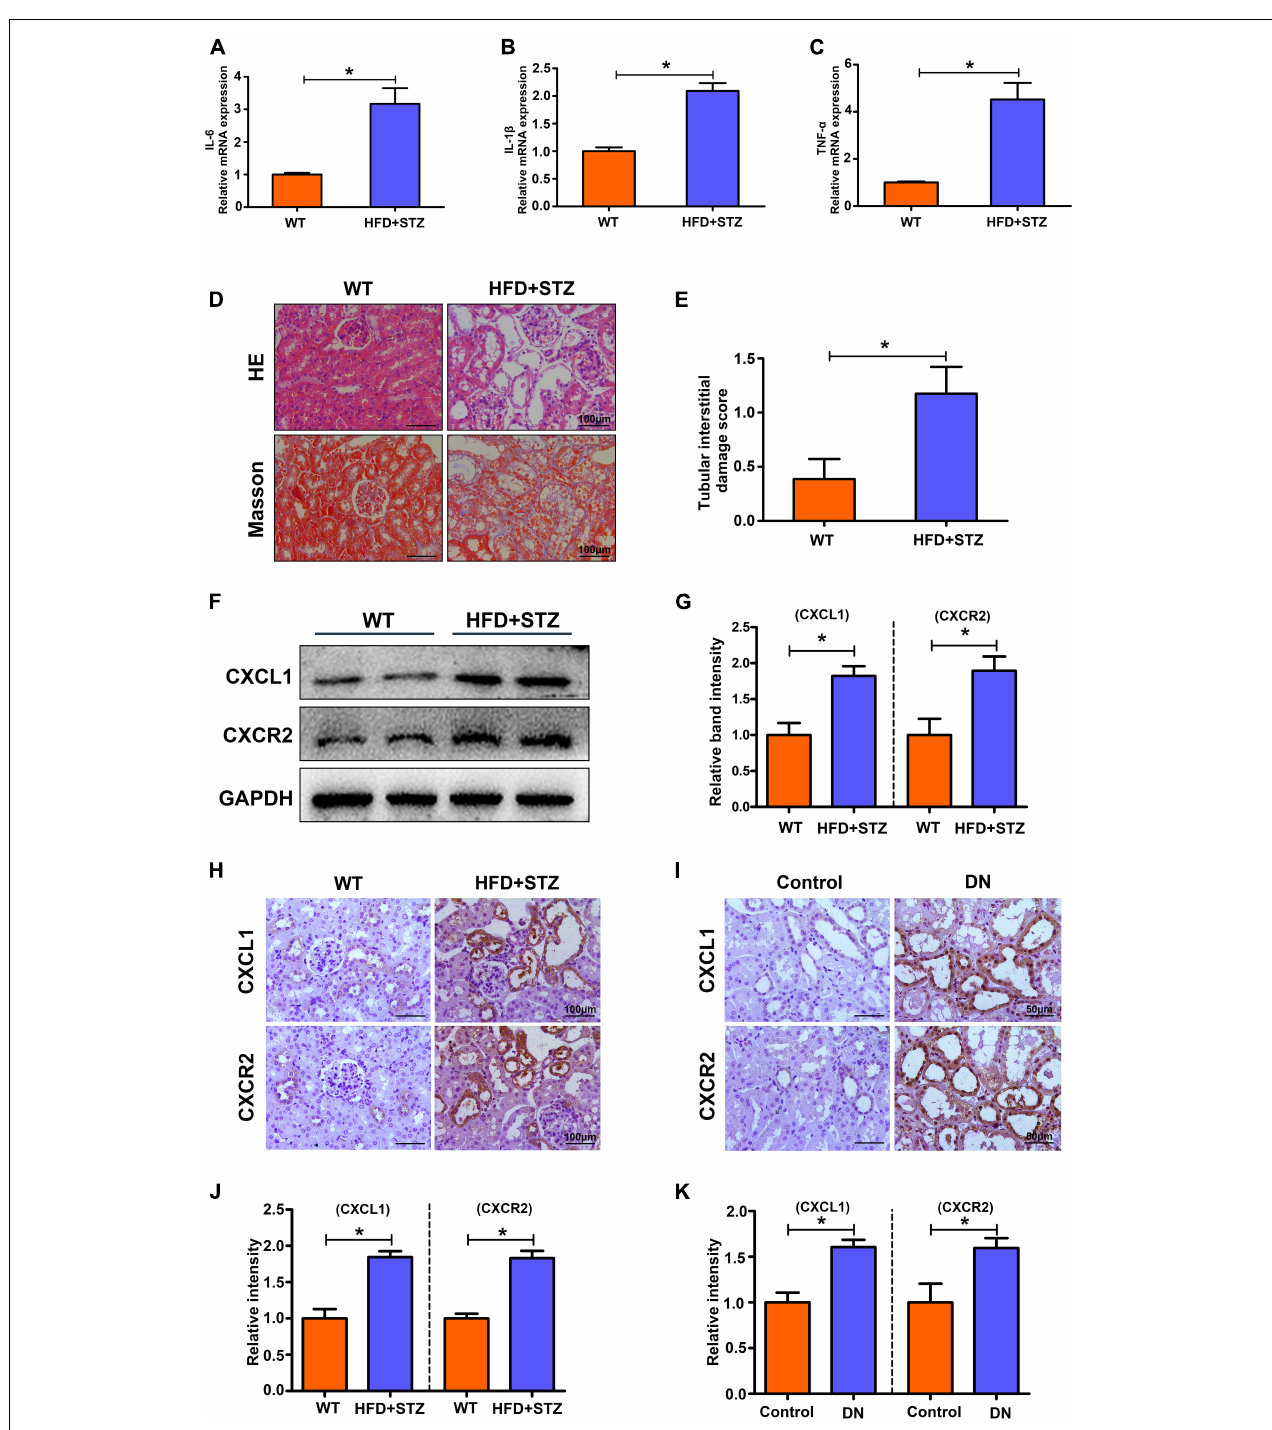
FIGURE 2 | Increased inflammation levels and upregulated CXCL1 or CXCR2 expression in the kidneys of HFD + STZ-induced DN mice and patients. The mRNA levels of IL-6 (A) , IL-1 β (B) and TNF- α (C) in mouse kidneys. (D) HE and Masson staining to detect pathological changes in the kidneys of WT and HFD + STZ mice. (E) Tubular interstitial damage scores of the kidney. (F,G) CXCL1 and CXCR2 expression was detected by WB analysis. (H,J) IHC staining was used to detect CXCL1 and CXCR2 expression in the kidneys of WT and HFD + STZ mice. (I,K) IHC staining was used to detect CXCL1 and CXCR2 expression in renal tissue from patients with renal biopsy. Magnification = 200 × . Values are the mean ± SD. Mice n = 6/group, patients n = 6/group. * p < 0.05 compared with the control group.